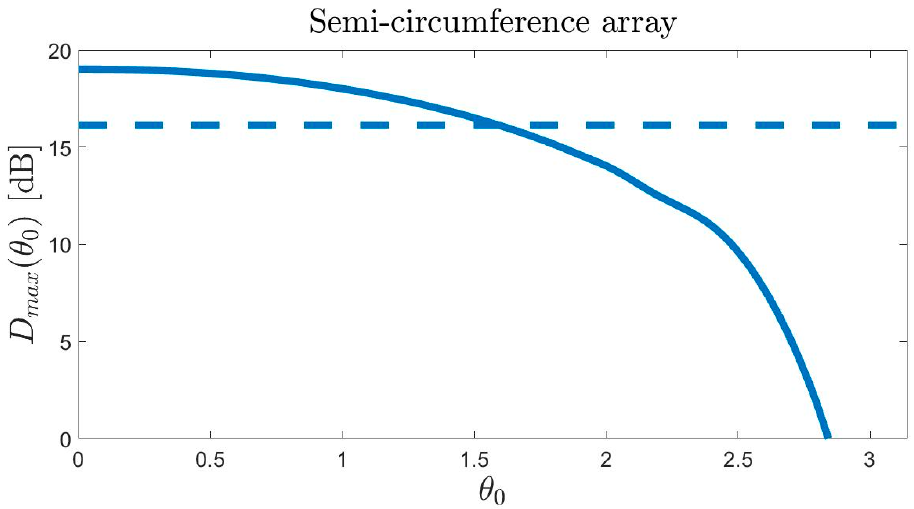
Figure 5. The behavior in dB of the maximum directivity D max ( θ 0 ) of the semi-circumference array (solid blue line) in Figure 4. The dashed line represents the corresponding value of D max .